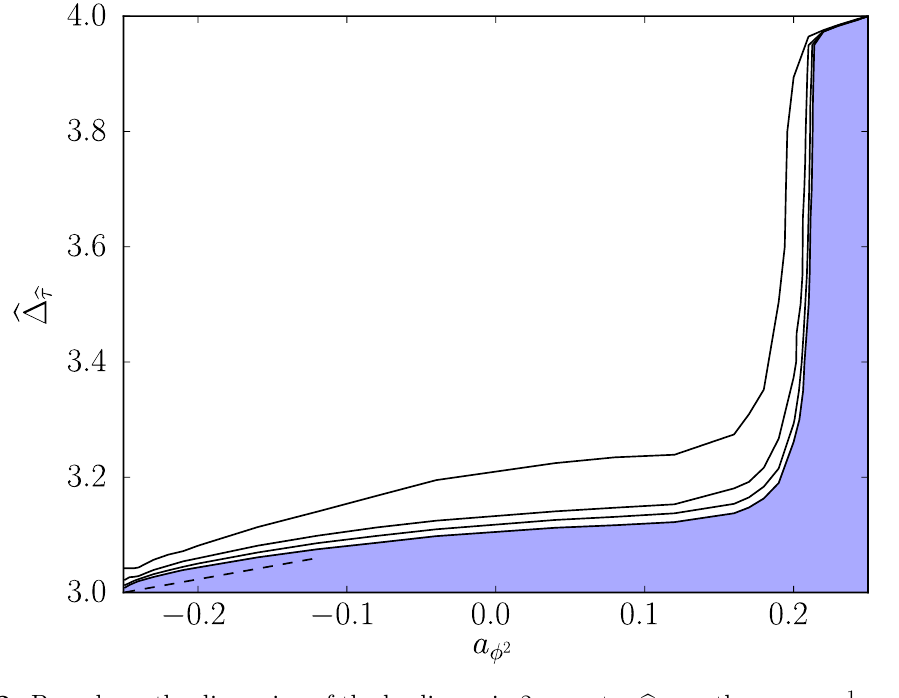
Figure 2. Bounds on the dimension of the leading spin 2 operator with our best estimate for the allowed region shaded in blue. The curves have n max = 5 , 6 , 7 , 8 in the notation of [49, 50]. As for the number of derivative components being kept in each crossing equation, these correspond to 21 , 28 , 36 , 45 respectively. The dotted line shows the maximum pos- sible value for b ∆ from leading order conformal perturbation theory under the assumption that the b τ Ising model is the 3d CFT with the lowest central